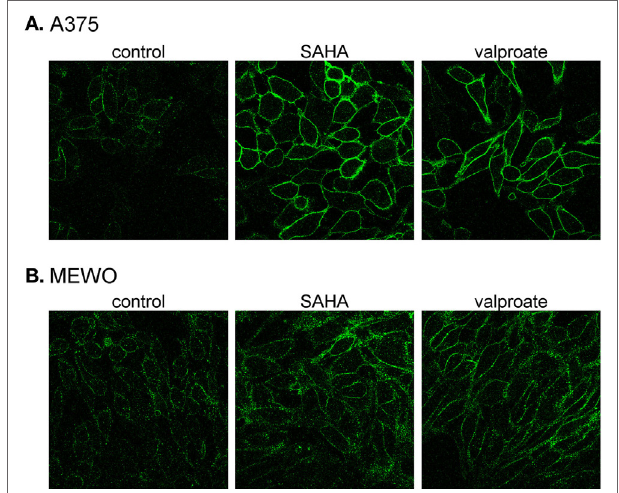
FigUre 3 | histone deacetylase inhibitor treatment increases PMca4b abundance in the plasma membrane . (a) BRAF-mutant A375 and (B) BRAF wild-type MEWO cells were treated with 1 µM SAHA, or 2 mM valproate for 48 h; then, the intracellular localization of PMCA4b was analyzed by immunofluorescence staining with anti-PMCA4b antibody (JA3). Images were taken by confocal microscope with a 60 ×